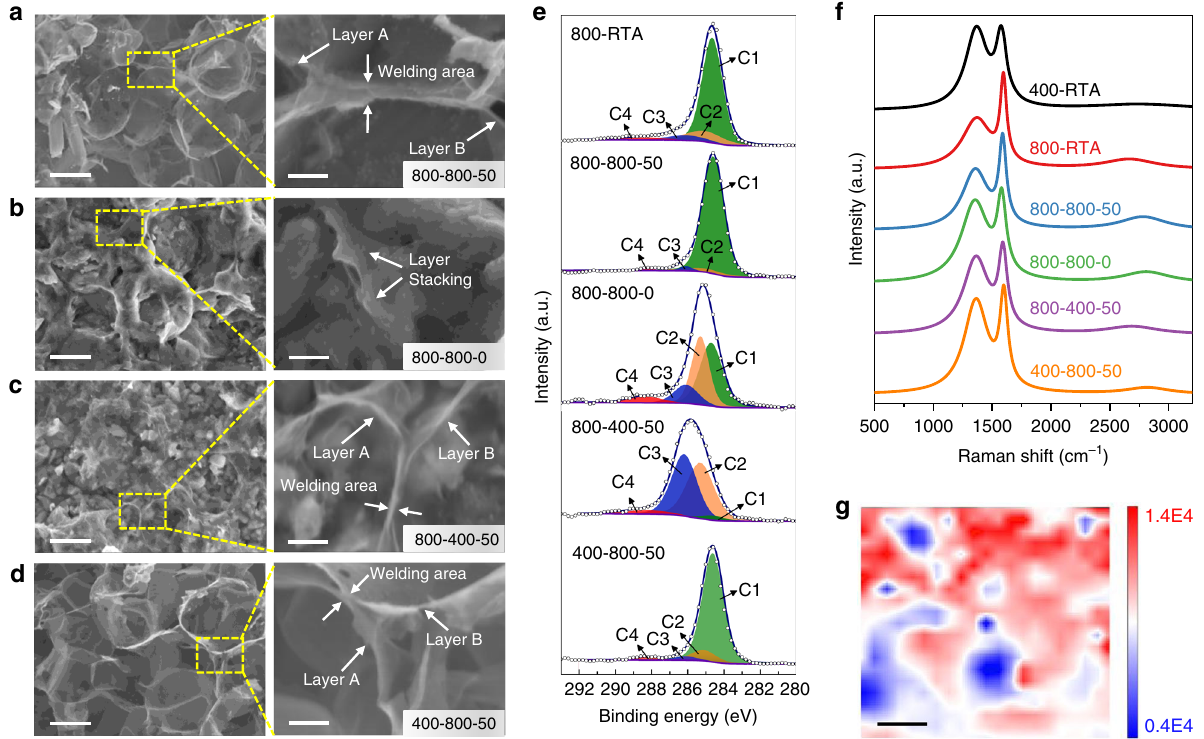
Fig. 3 Sructure evolution during hot-pressing. a – d SEM images of the reinforcement morphology after etching the surface Cu layer in a 800-800-50, b 800-800-0, c 800-400-50 and d 400-800-50. Scale bar, 1 μ m for the left panel and 200 nm for the right panel ( a – d ). e , f Deconvoluted XPS C1s spectrum and ( f ) Raman spectra of 3D-GLNN in the composite powders (400-RTA and 800-RTA) and bulks (800-800-50, 800-800-0, 800-400-50 and 400-800-50). g Surface Raman map of 800-800-50, the peak density of the 3D-GLNN G band (1580 cm − 1 ) is imaged in red. Scale bar, 2 μ m ( g